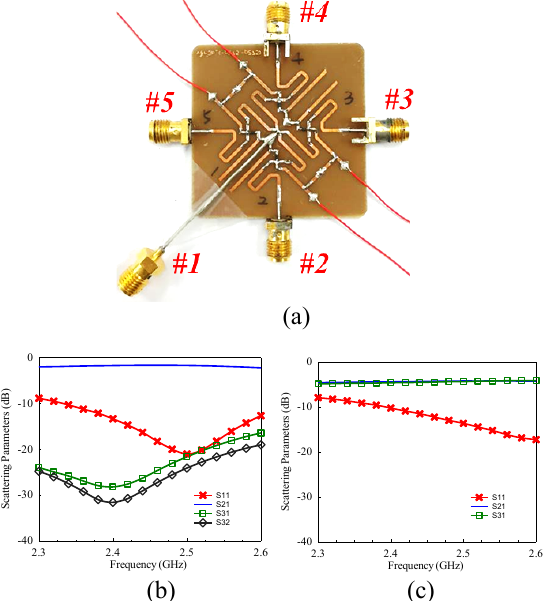
Figure 11: (a) Photo of the one-to-four switching power divider. (b) Scattering parameters corresponding to the switch-on state of port 2. (c) Scattering parameters corresponding to the switch-on states of ports 2 and 3.